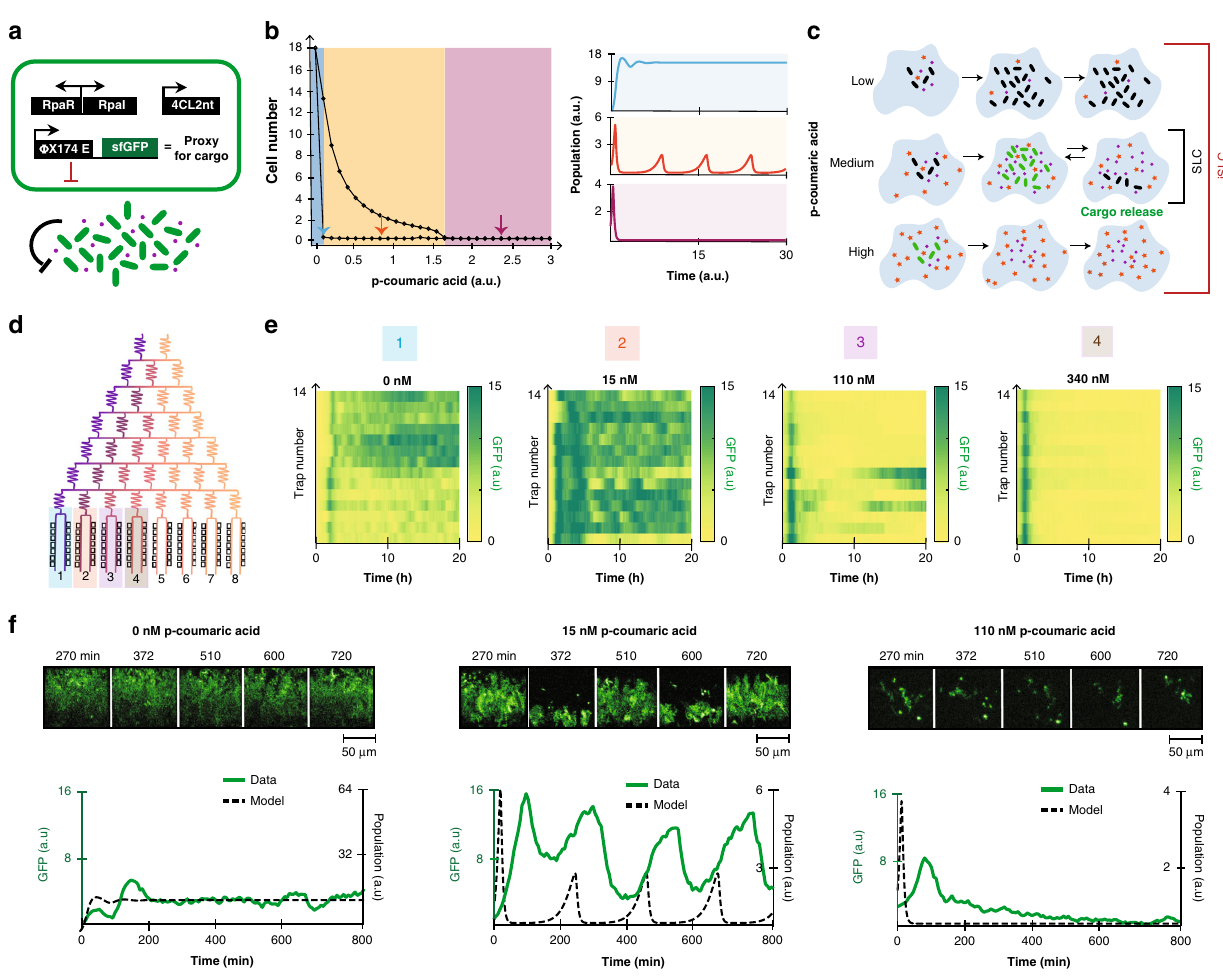
Fig. 2 Characterization of the inducible syncronized lysis circuit (iSLC). a Genetic diagram of the iSLC strain. b Simulations of the mathematical model showing three different dynamics at low (blue), medium (orange) and high (purple) inducer values. Medium values are predicted to result in sustained oscillations. Left: steady state maximum and minimum cell population values are plotted for a range of inducer concentrations. Right: simulated time traces for three representative p-coumaric acid values predict three emergent population dynamics. c Comparison between the iSLC and SLC dynamics based upon the model simulations in part b. d Diagram of the micro fl uidic device used to generate the inducer gradient. e Heatmaps representing the fl uorescence time traces of all 14 traps present per column of the device. GFP signal is used as a proxy for population density. Four different inducer conditions are shown: low, medium, high, extra high, respectively. f Top: representative time series images from the fl uorescence channel with three different inducer concentrations: low, medium, high, respectively. Bottom: fl uorescence time traces plotted together with computer simulations of the mathematical model. For the simulation (dashed lines) time units are arbitrary, therefore the correspondence is strictly qualitative. Source data are provided as a Source Data fi